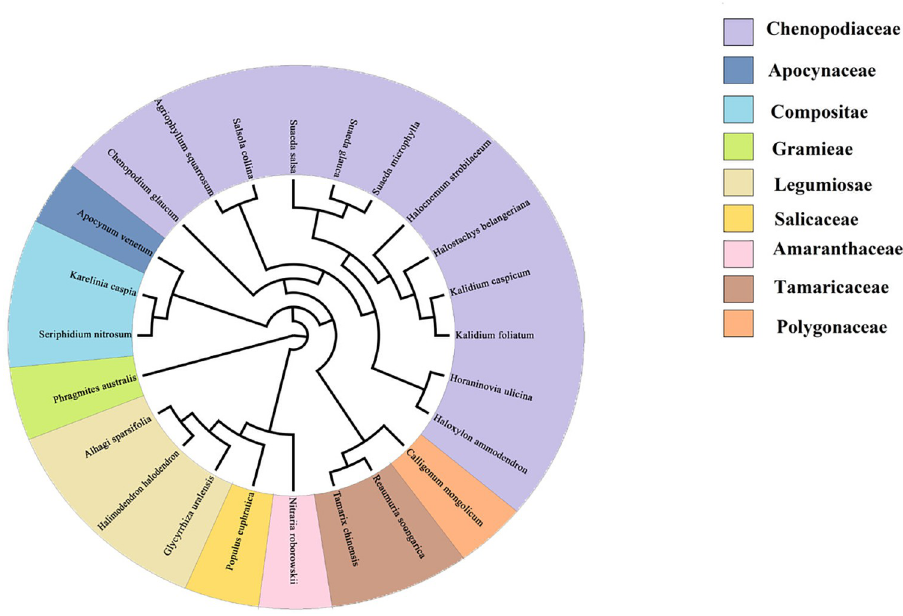
Fig 2. Plant phylogenetic tree of the sample